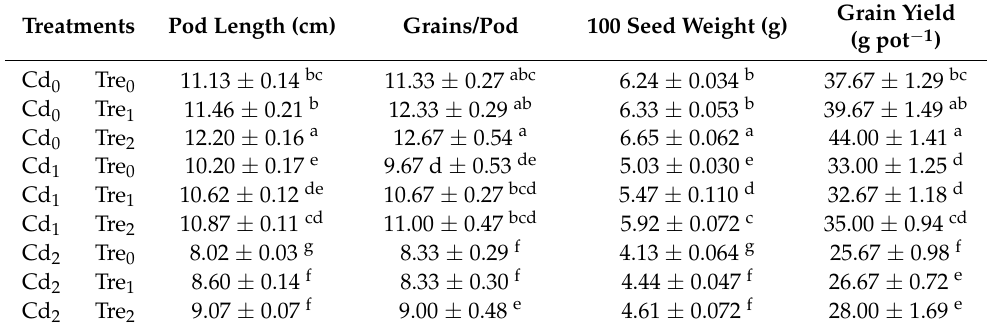
Table 3. Effect of trehalose supply on yield traits of mung bean crop under different levels of Cd stress. Treatments Pod Length (cm) Grains/Pod 100 Seed Weight (g)